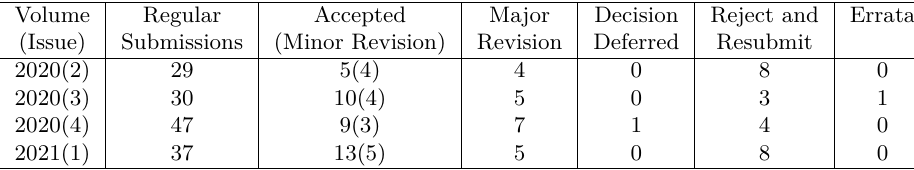
Table 1: Submission statistics for issues 2020(2), 2020(3), 2020(4),